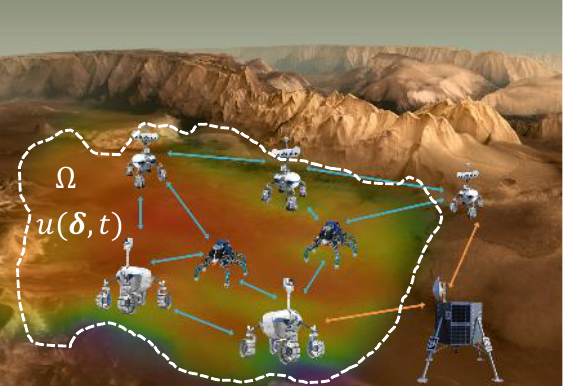
Figure 1. A swarm of autonomous agents explores an unknown physical process u ( δ , t ) over spatial coordinate δ and time t in the spatial domain Ω .